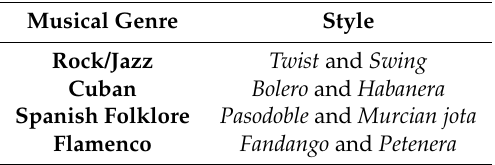
Table 1. Musical genres and styles used in the